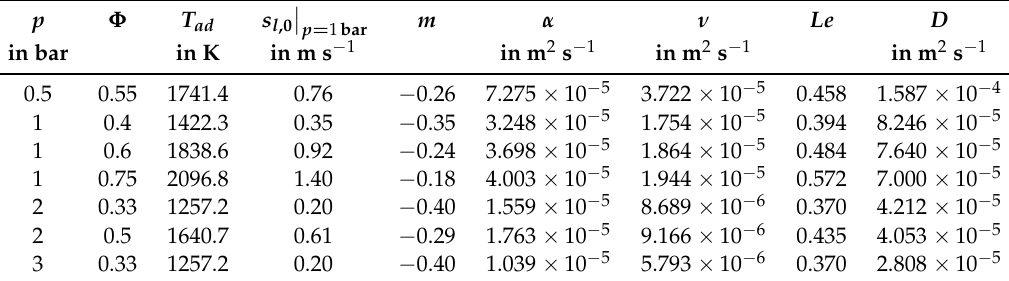
Table A1. Parameters for the mixture diffusivity